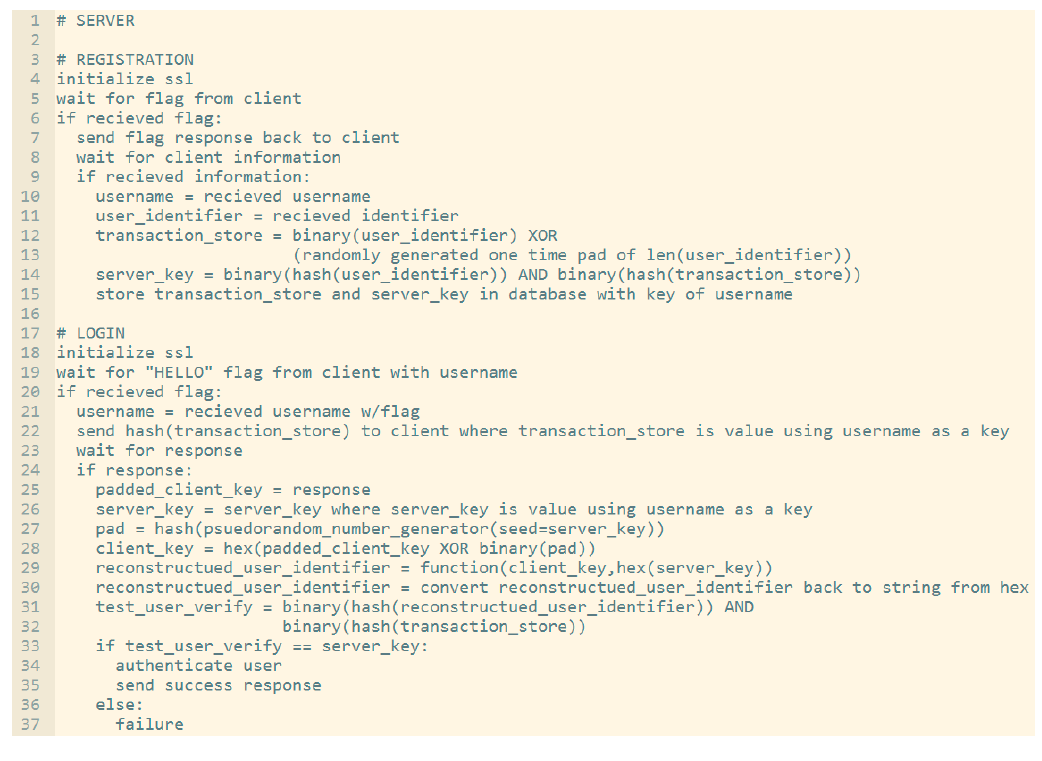
Figure 7. Code of server.